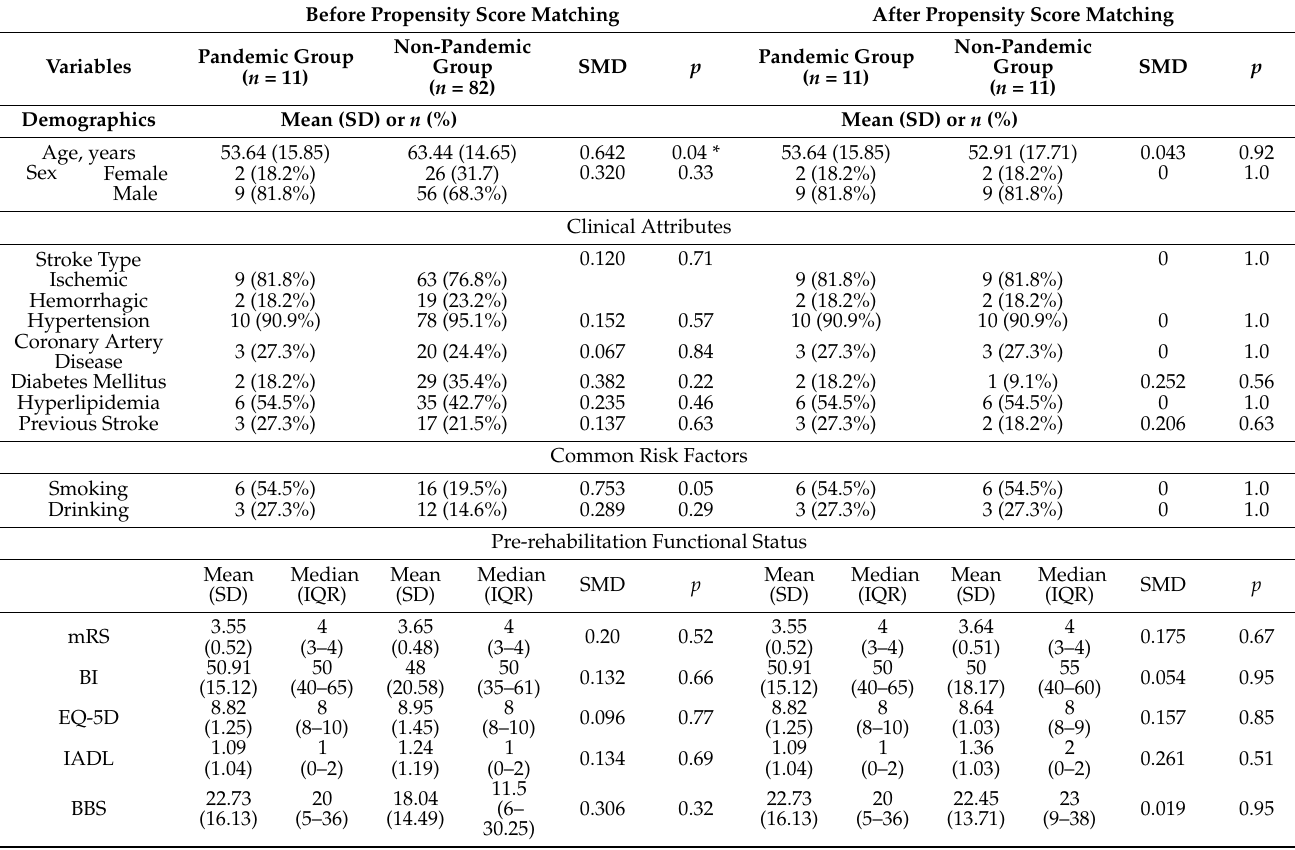
Table 1. Patients’ characteristics before and after propensity score matching